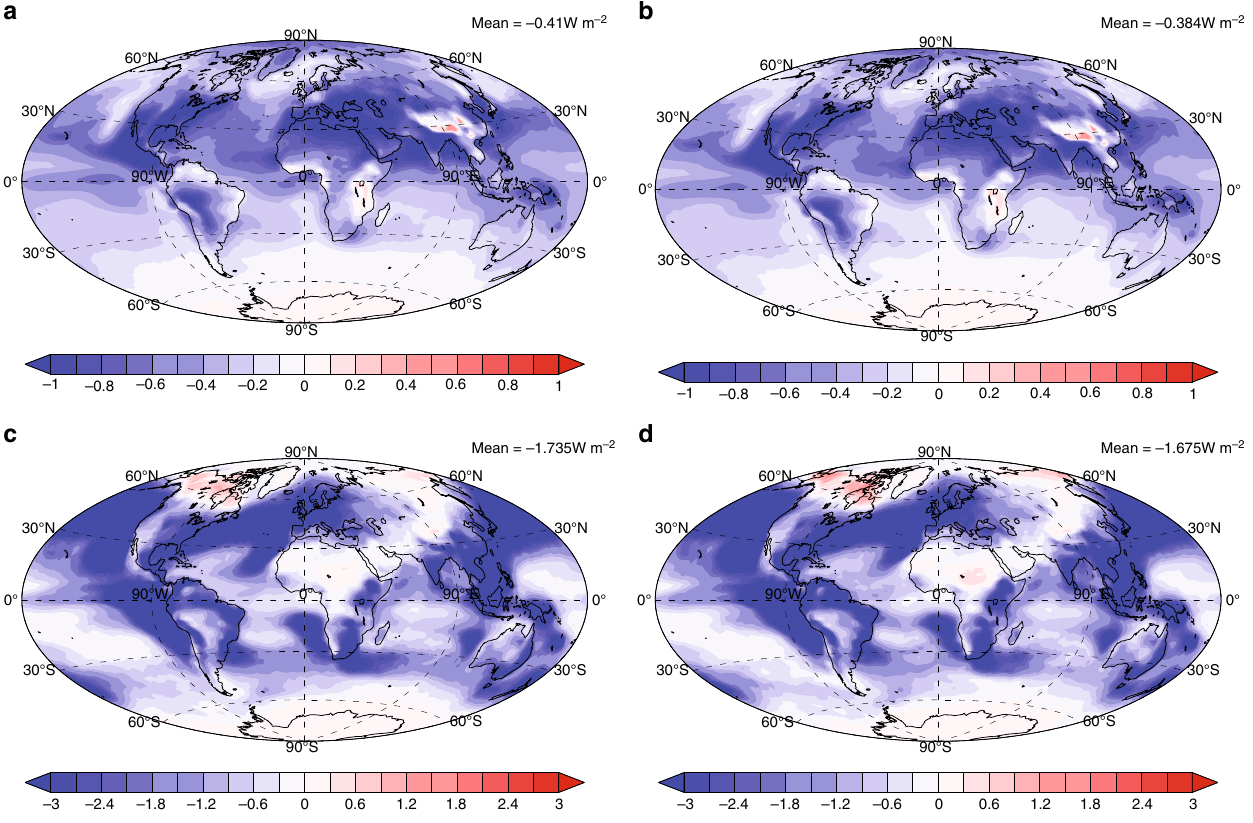
Fig. 2 The radiative forcing of anthropogenic aerosol with different preindustrial schemes. a – d The direct radiative forcing (DRF; a , b ) and indirect radiative forcing (IRF; c , d ) of anthropogenic aerosol with the preindustrial values from PIemi ( a , c ) and PIall ( b , d ). The global average radiative forcing is shown on the top right of each